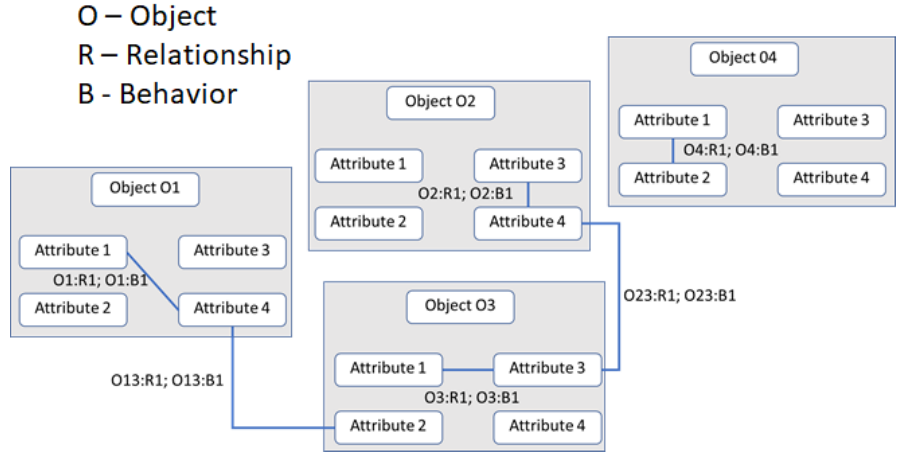
Figure 8. A knowledge structure modeling intra-object and inter-object behaviors.